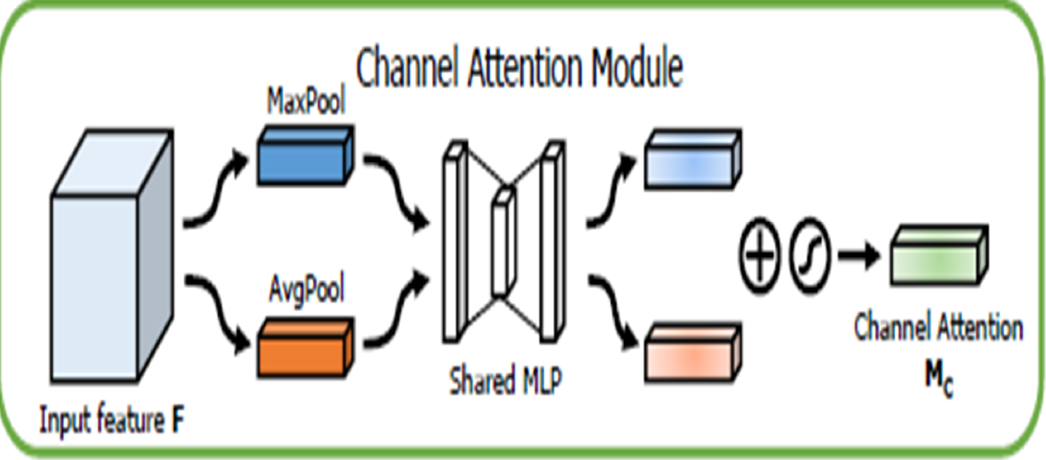
Figure 3. Illustration of a channel attention module.